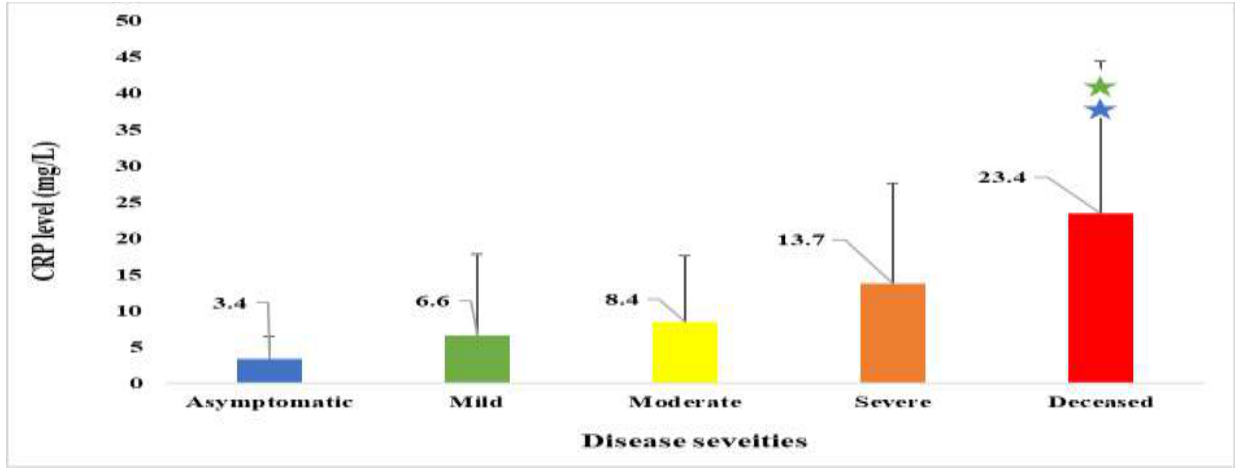
Figure 7: C-reactive protein (CRP) levels in 100 patients with COVID-19 of different severities.